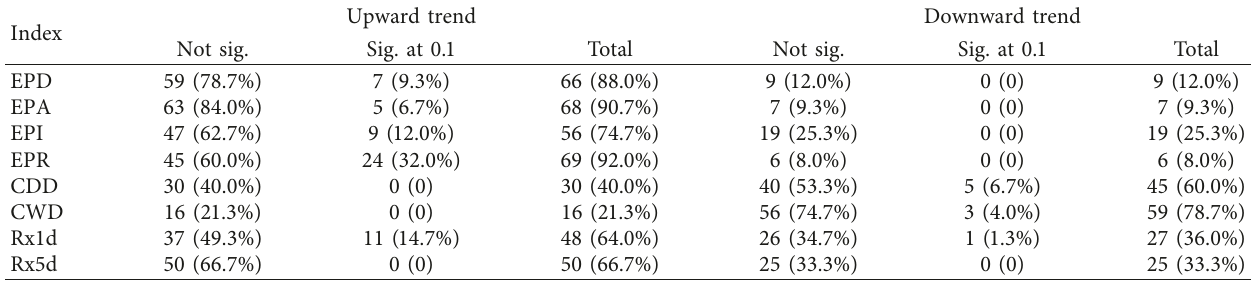
Table 5: Number and percentage of stations showing upward and downward trends for each extreme precipitation index. Upward trend Downward trend Index